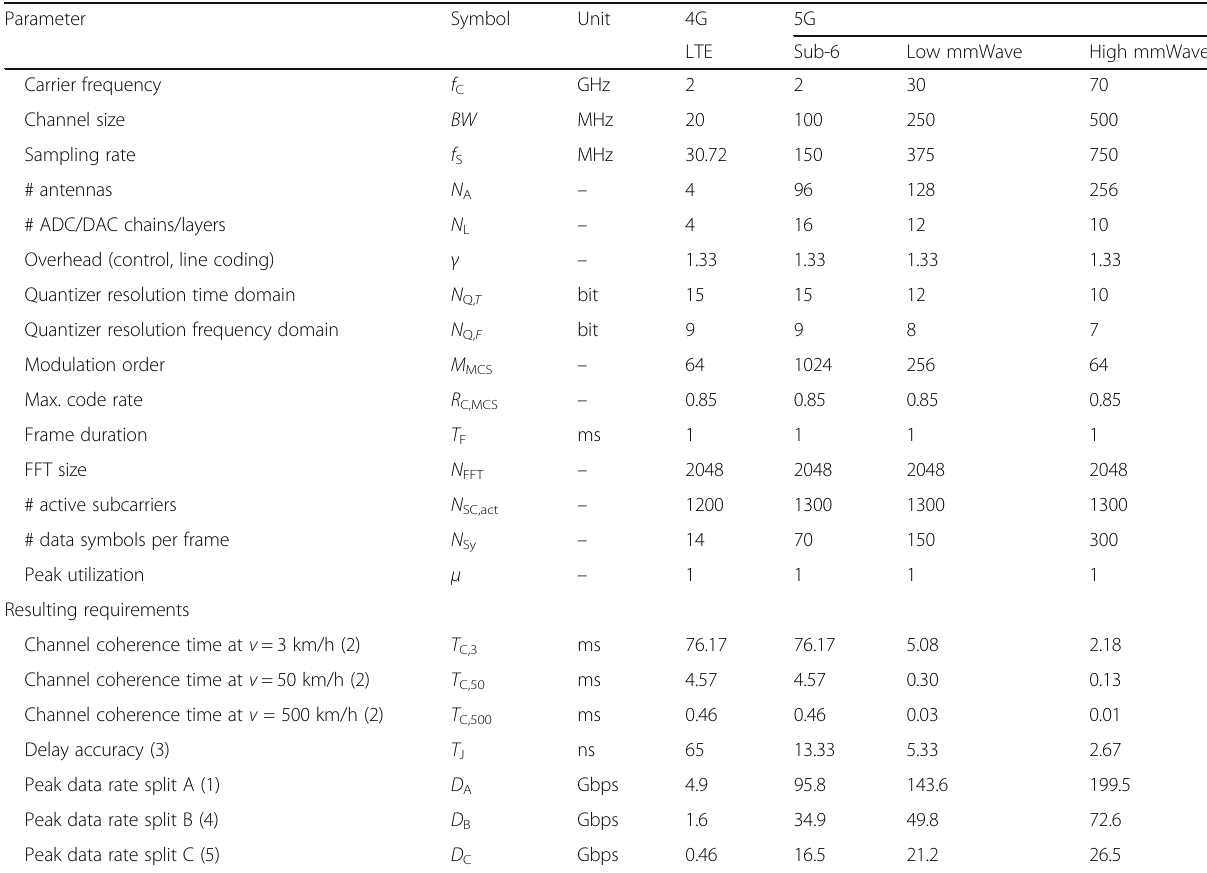
Table 1 Potential parametrization of a 5G radio access network using different frequency bands Parameter